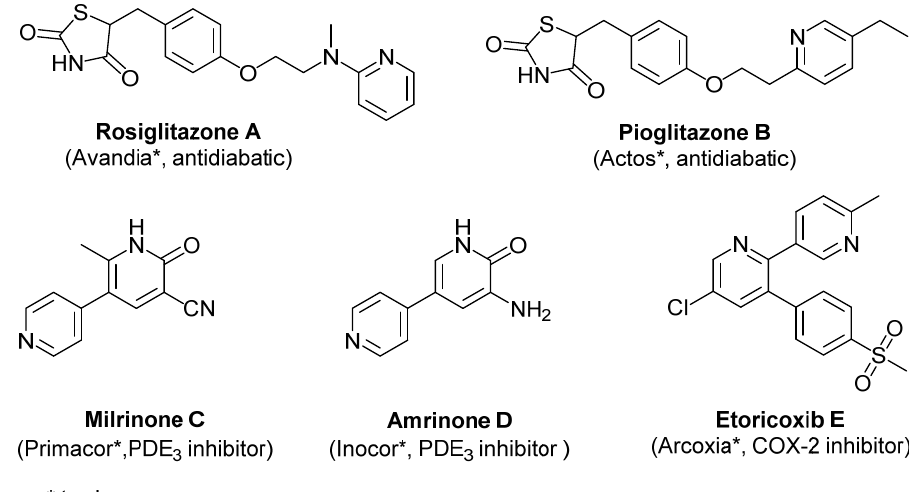
Figure 1. Clinically ‐ used pyridine ‐ containing compounds.